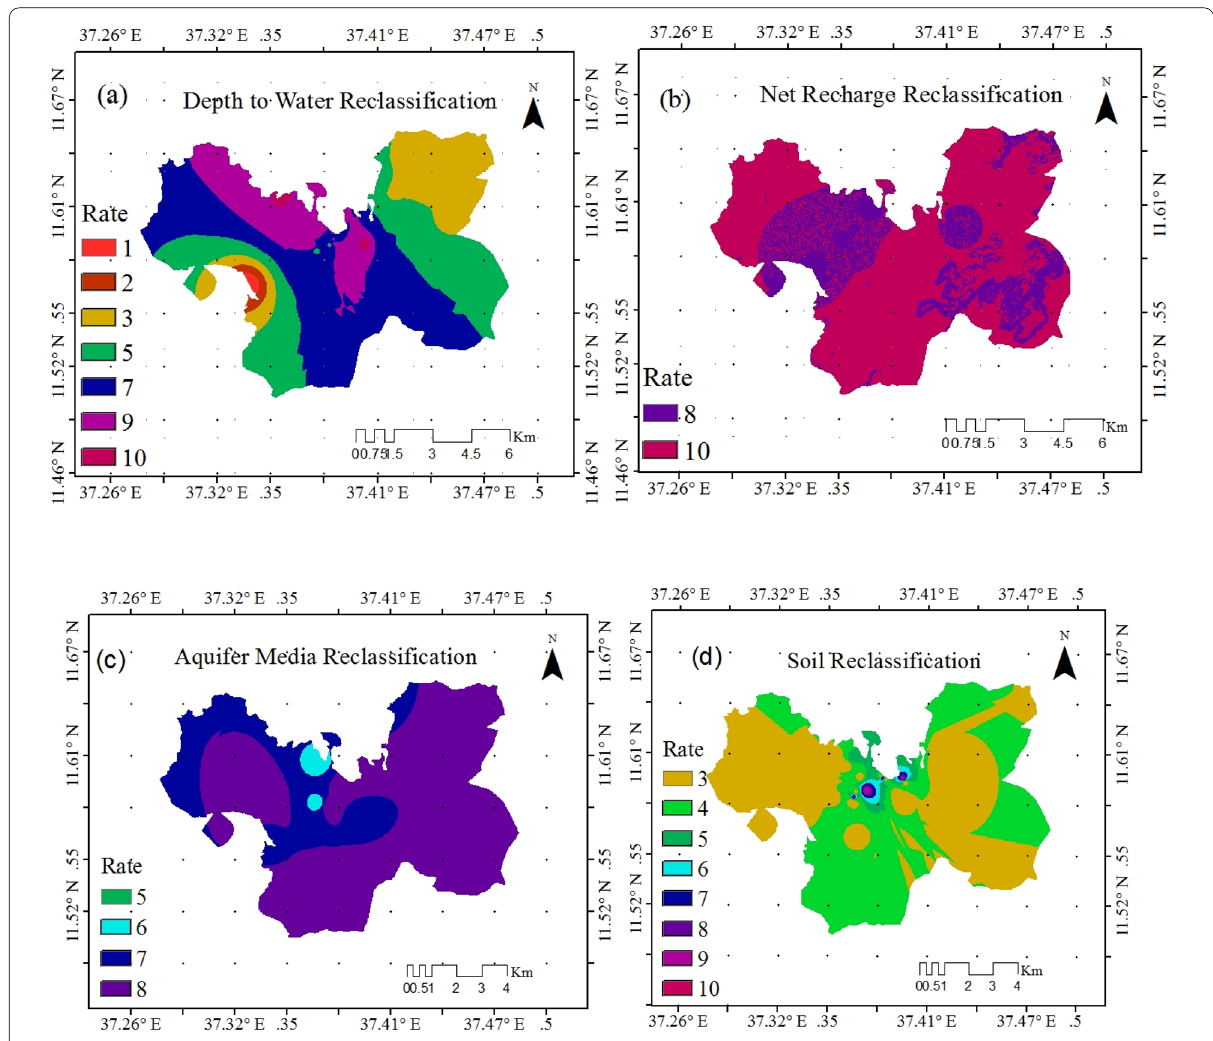
Fig. 2 The rate and spatial distribution of vulnerability parameters: a Depth to the water table, b Recharge, c Aquifer Media, d Soil